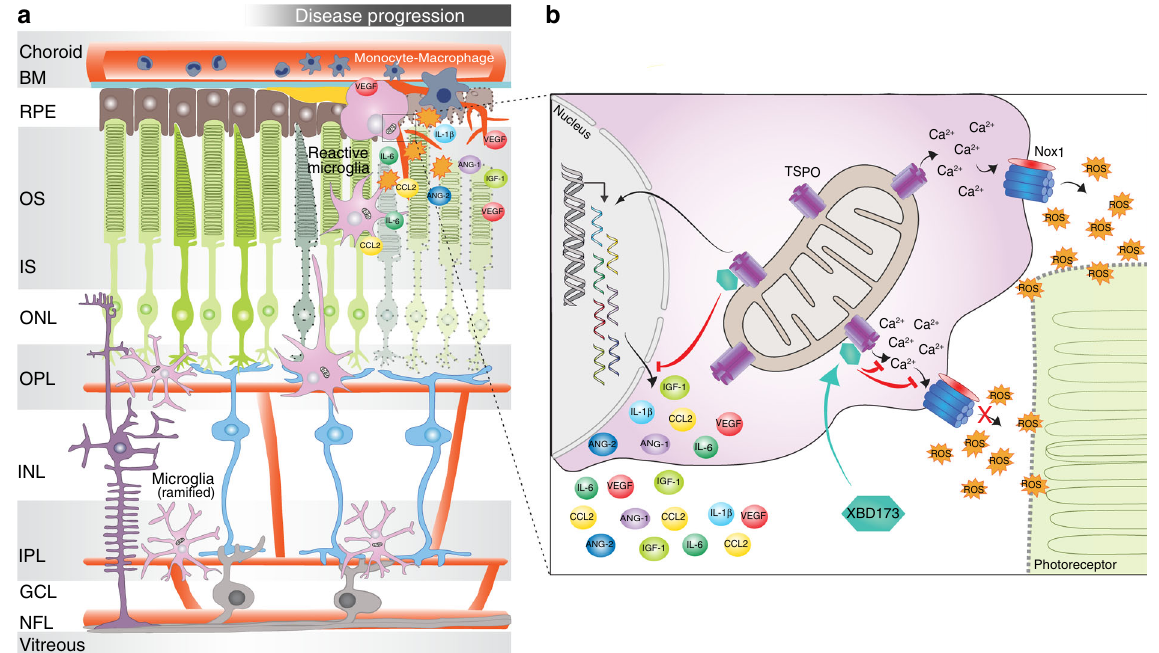
Fig. 9 Model of TSPO-mediated ROS production in retinal phagocytes. a In the healthy retina, resident microglia populate the plexiform layers. With their long protrusions, they constantly scan their environment and phagocytose cell debris. Different insults in the RPE and photoreceptor layer rapidly alert microglia. Resident microglia transform into ameboid phagocytes, migrate to the lesion sites and recruit macrophages from the periphery. b In response to these pathological signals, microglia increase pro-in fl ammatory and pro-angiogenic cytokine expression to resolve neuroin fl ammation and promote tissue recovery. Reactive microglia also upregulate mitochondrial TSPO leading to increased cytosolic calcium levels, which is essential for NOX1-mediated ROS production. Chronic activation of microglia may be detrimental and promote retinal degeneration. Binding of the synthetic ligand XBD173 to TSPO limits in fl ammatory responses and inhibits the increase of cytosolic calcium levels thus preventing from ROS damage. XBD173 supports the conversion of reactive microglia towards a neuroprotective phenotype, limiting pathological CNV. BM Bruch ’ s membrane; OS outer segment; IS inner segment; ONL outer nuclear layer; OPL outer plexiform layer; INL inner nuclear layer; IPL inner plexiform layer; GCL ganglion cell layer; NFL nerve fi ber